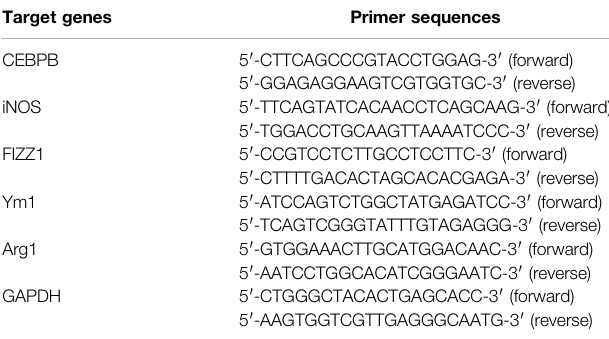
TABLE 1 | Primer sequences of genes by RT-qPCR. Target genes Primer